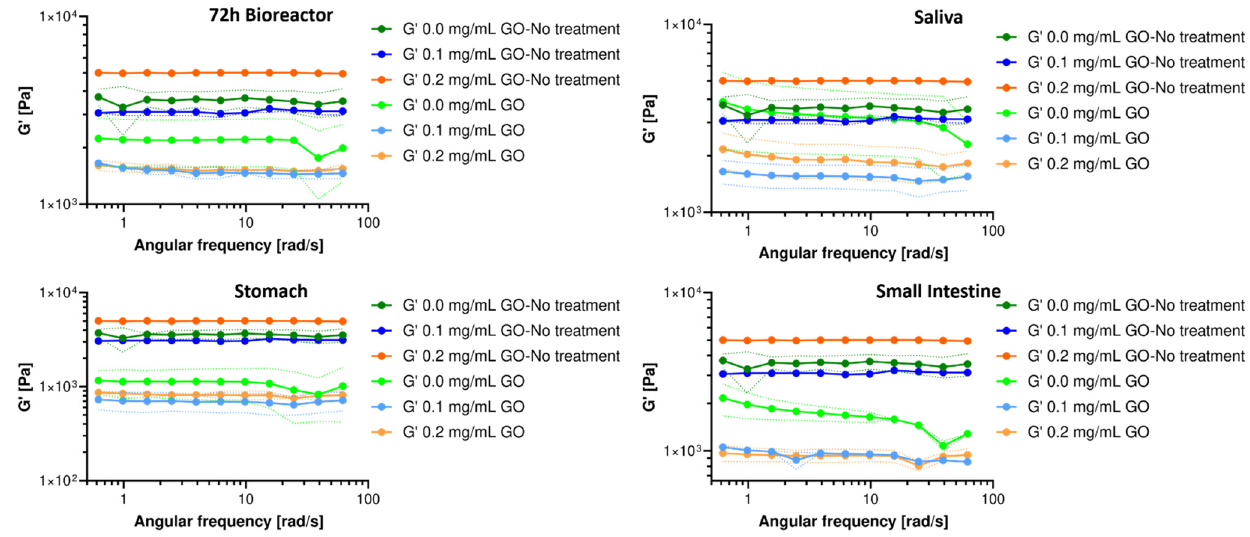
Figure 5. Storage (G’) modulus for hydrogels after exposure to milli-bioreactor operation for 72 h and human gastrointestinal tract (GIT) simulated media and the comparison with a hydrogel in the absence of each treatment.